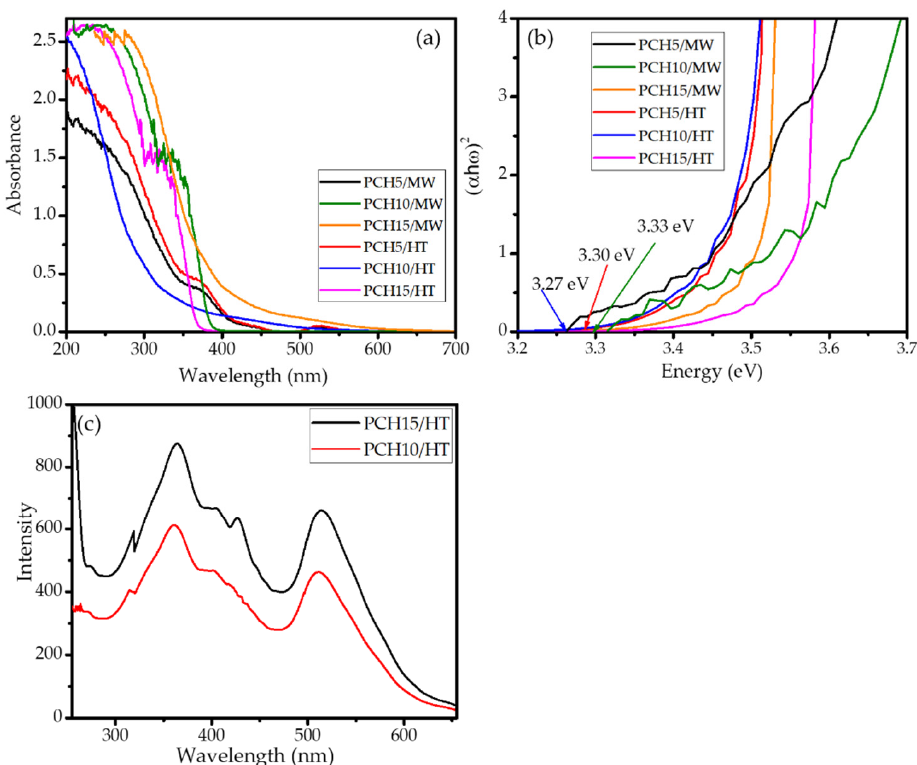
Figure 7. ( a ). Exemplary UV ‐ DRS spectra of ZnO/SiO 2 ‐ PCH samples; ( b ). Tauc plots of ZnO/SiO 2 ‐ PCH samples ( c ) PL spectra of PCH10/HT in comparison with PCH samples ( c ) PL spectra of PCH10/HT in comparison with PCH15/HT.